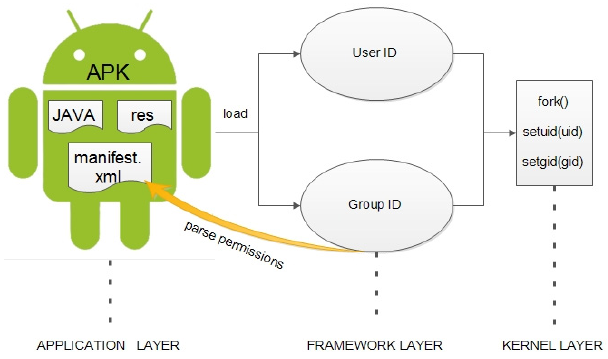
Figure 4. The system permission mechanism.